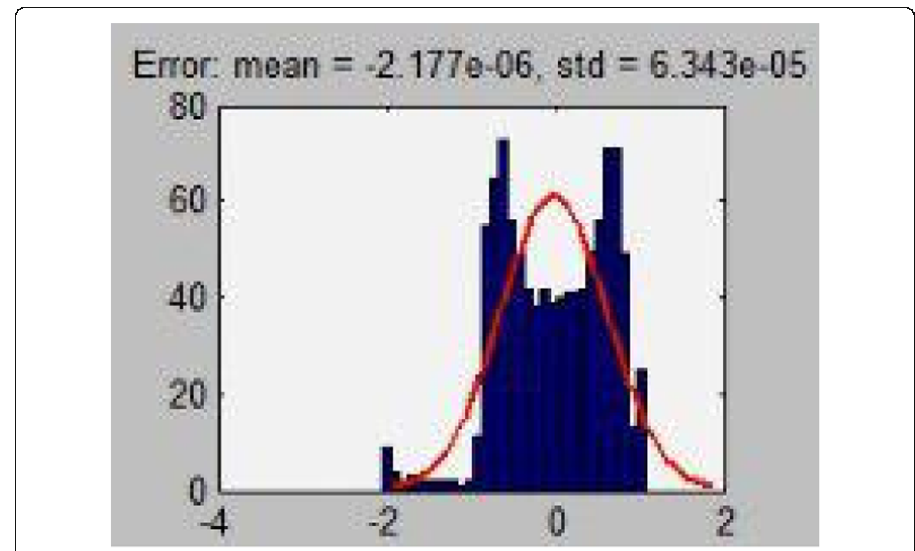
Fig. 15 The FCM MSE. There are some clustering methods like K-Means, FCM, and subtractive. To find which one is the best for our research, we have clustered the customers using K-Means, FCM, and subtractive clustering methods and compared the methods ’ MSEs. The MSEs (Mean-Square Error) of the FCM is shown in Fig. 15. The error mean is = − 2.177e-0.6 and std. = 6.343e-0.5. The Mean squared error (MSE) measures the average of the squares of the errors